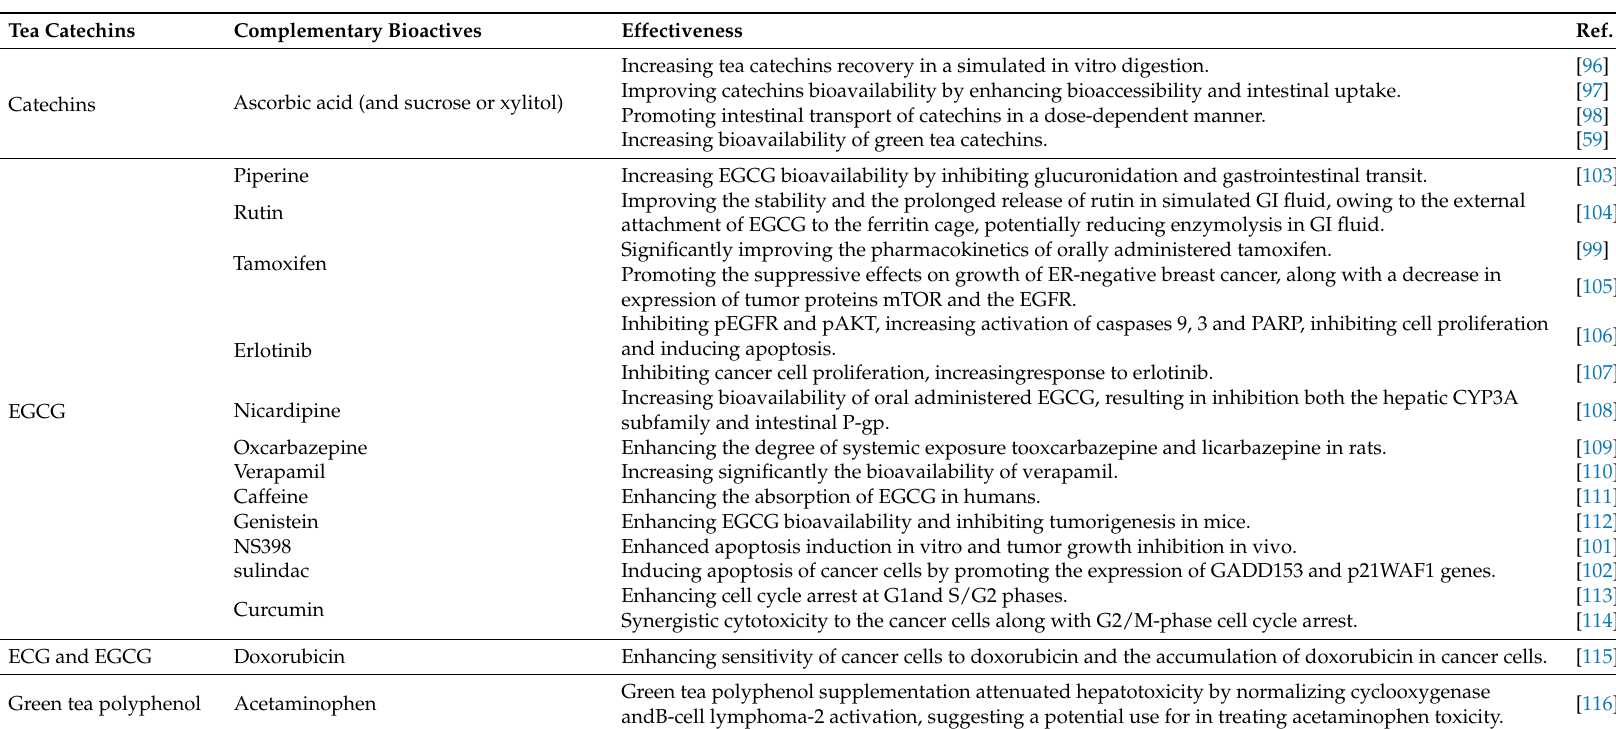
Table 3. Improvement of biological activities by co-administration catechins with other complementary